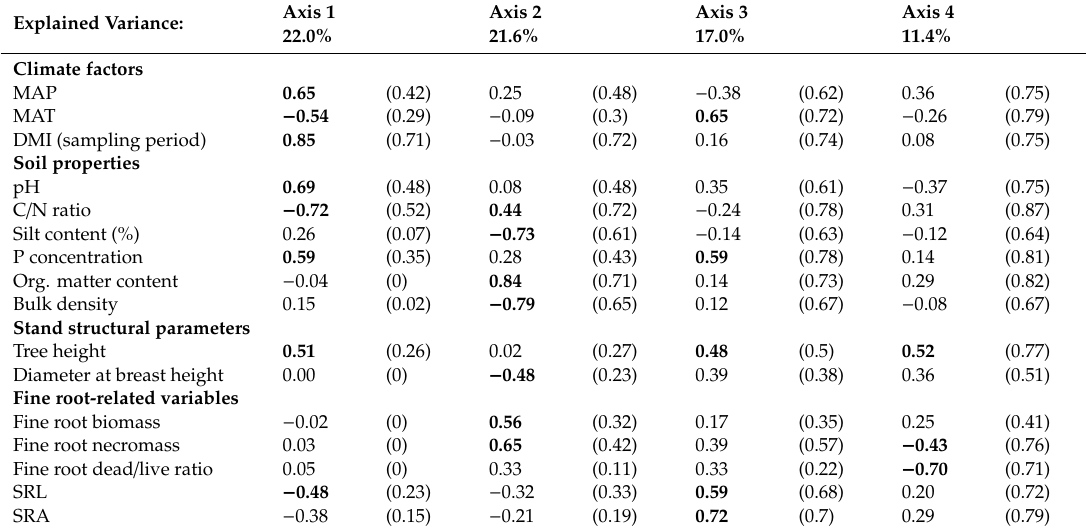
Table 5. Results of the principal components analysis for the drought inventory in 2018. Given are the loadings of the selected variables along the four axes with the highest explained variance in the dataset. Bold numbers mark the variables with the highest loading ( > 0.4) on the respective axis. The values in brackets give the cumulative fraction of variance explained by the variable. MAP = mean annual precipitation, MAT = mean annual temperature, DMI = de Martonne aridity index of the three months prior to